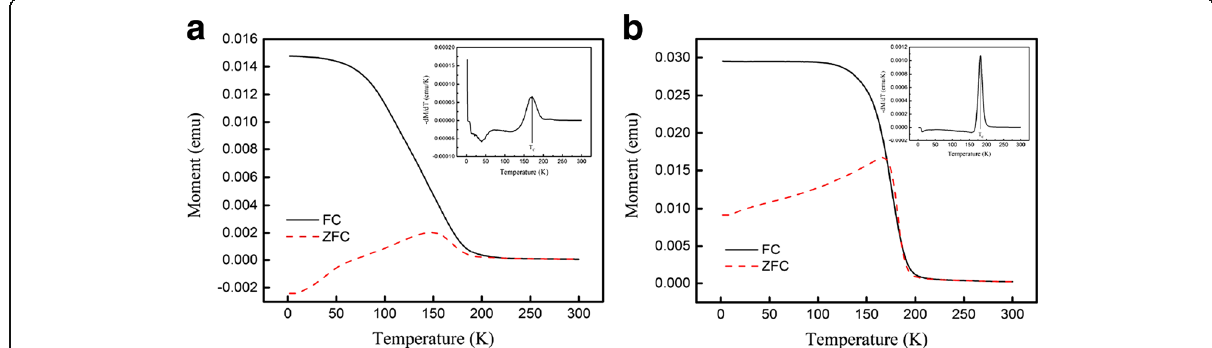
Fig. 9 Temperature dependence of the magnetizations of the (La 0.6 Pr 0.4 ) 0.67 Ca 0.33 MnO 3 nanoparticles post-annealed at ( a ) 800oC and ( b ) 1000oC. Insets are the - dM/dT curves versus the